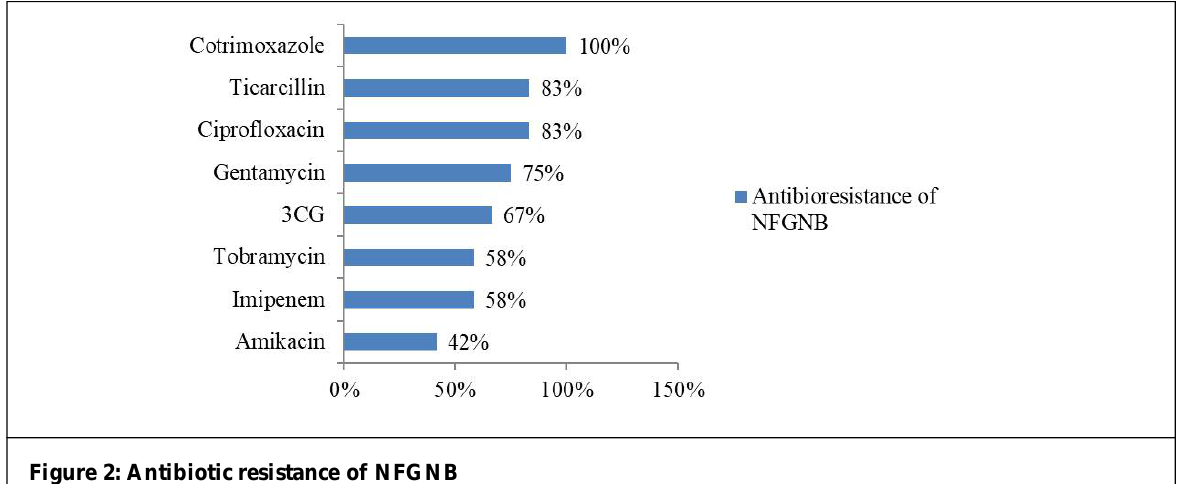
Regarding the isolates of NFGNB, the antibiotic resistance, varies from 42% (amikacin) to 100% (cotrimoxazole) (Figure 2).